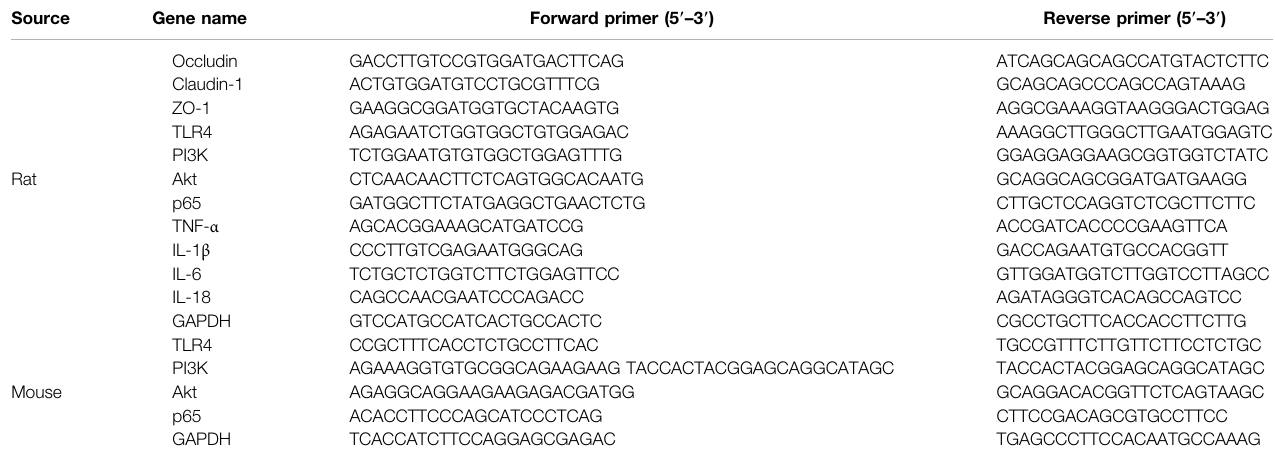
TABLE 1 | List of primers for real-time